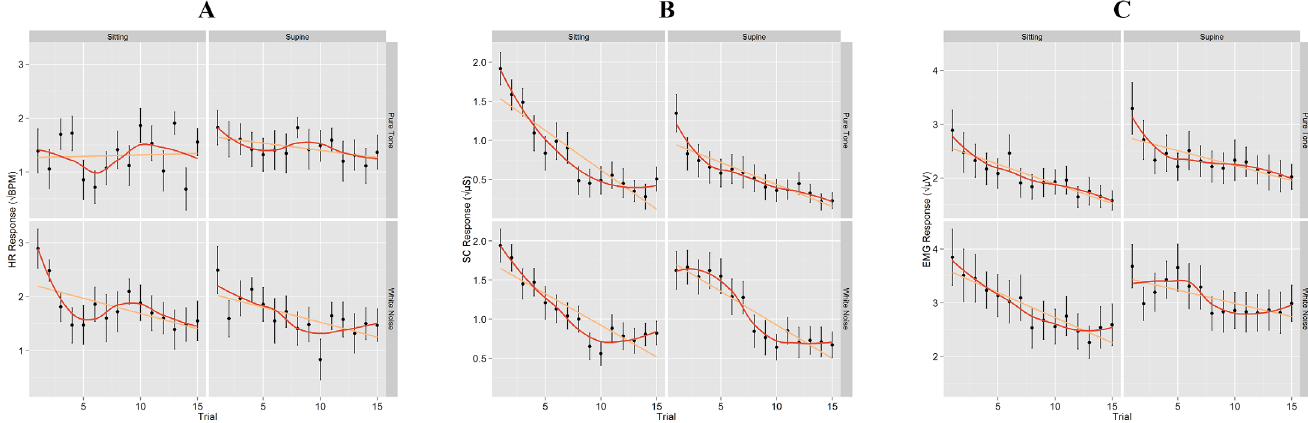
Fig 1. Group means for time course of HR (A), SC (B), and eye blink EMG (C) responses to sound presentations by stimulus bandwidth and subject ’ s posture.